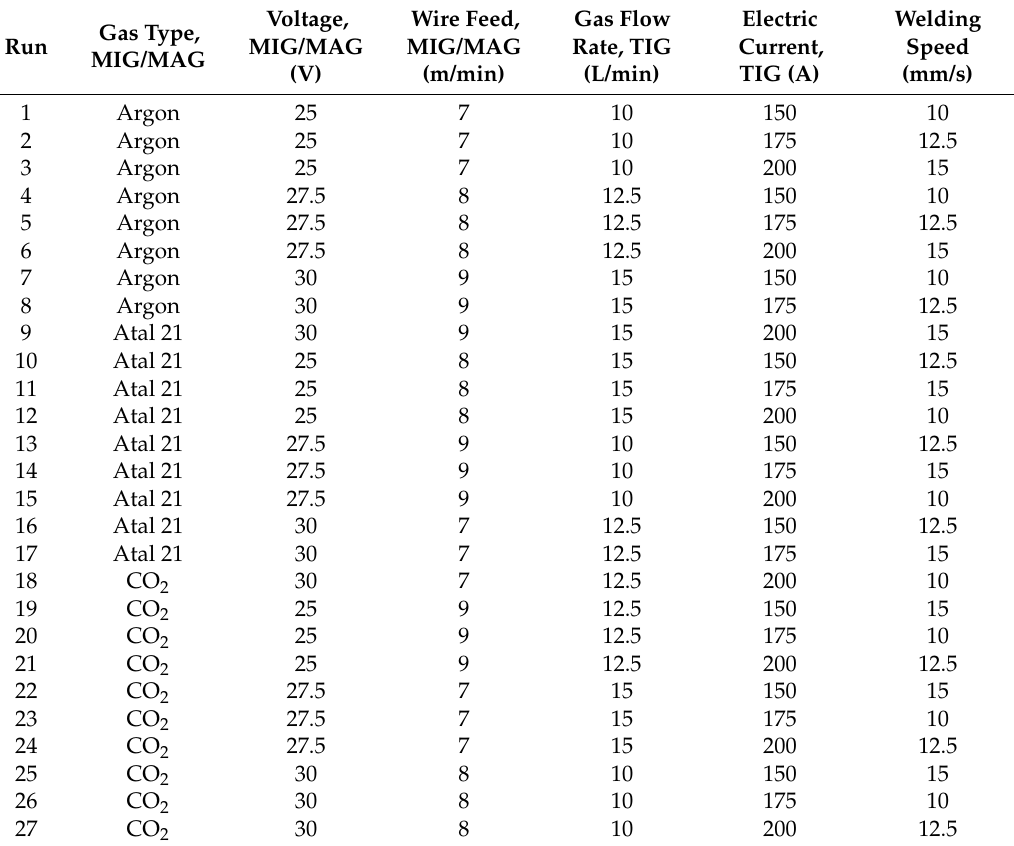
Table 1. Experimental matrix with the factors and respective